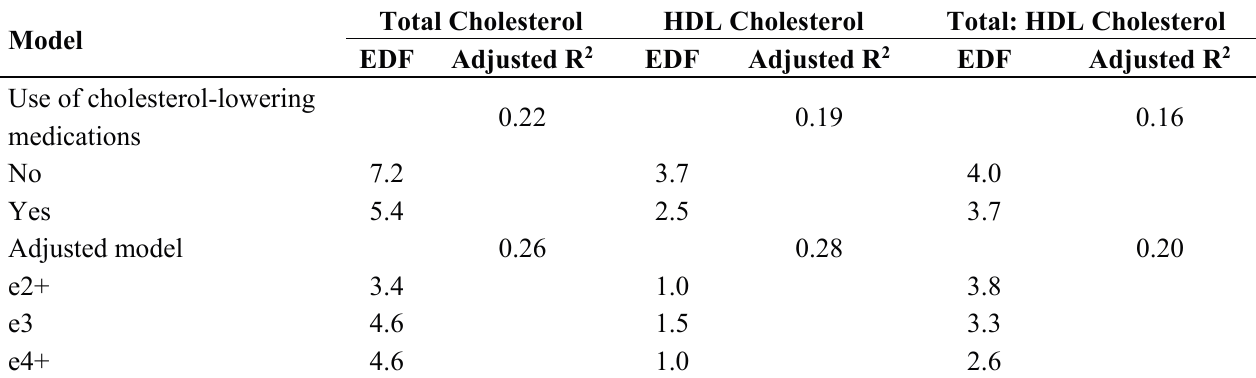
Table 4. EDF and adjusted R2 for trajectories of total, HDL, and total: HDL cholesterol ratio stratified according to use of cholesterol lowering medications, and APOE allele status adjusting for age of first using cholesterol lowering